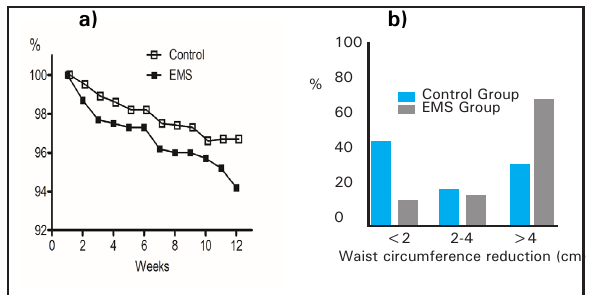
Figure 2. Effects of EMS on waist circumference. (a) Changes of waist circumference over the 12- week study period (ITT analysis set) EMS, electrical muscle simulation. P=0.027 by repeated measures ANCOVA. ITT, intention to treat. (b) Intergroup comparison of waist circumference reductions achieved during the study period. P=0.008 by